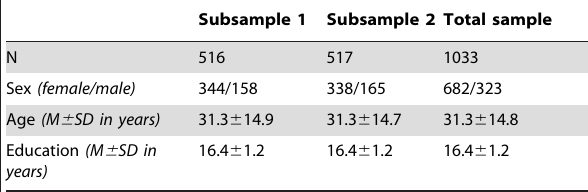
Table 1. Characteristics of respondents.